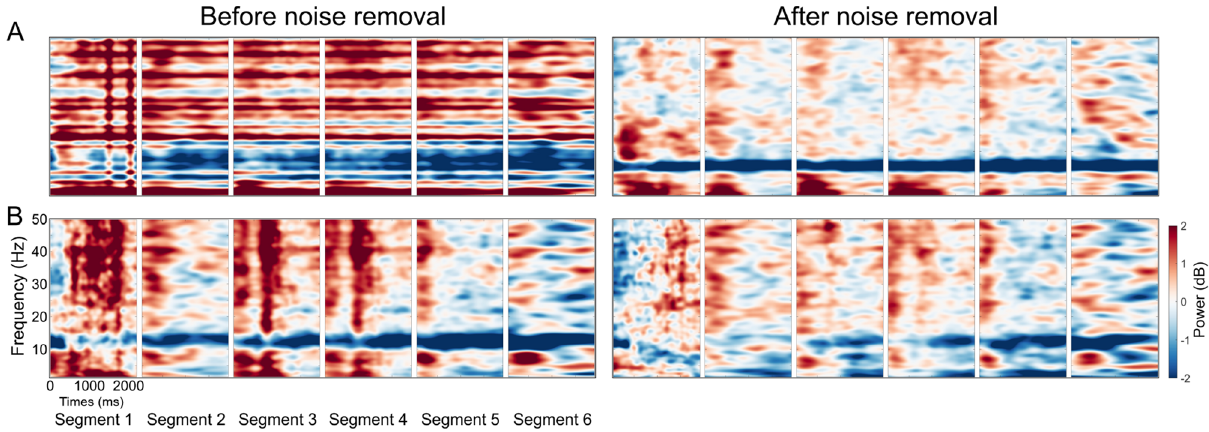
Figure 7. The RSC ERSP before and after noise removal. The RSC ERSP before and after noise removal at the participant level. The left figure shows the average ERSP for participants before noise removal. The right figure shows the average ERSP for participants after noise removal at: ( A ) one egocentric participant; and ( B ) one allocentric